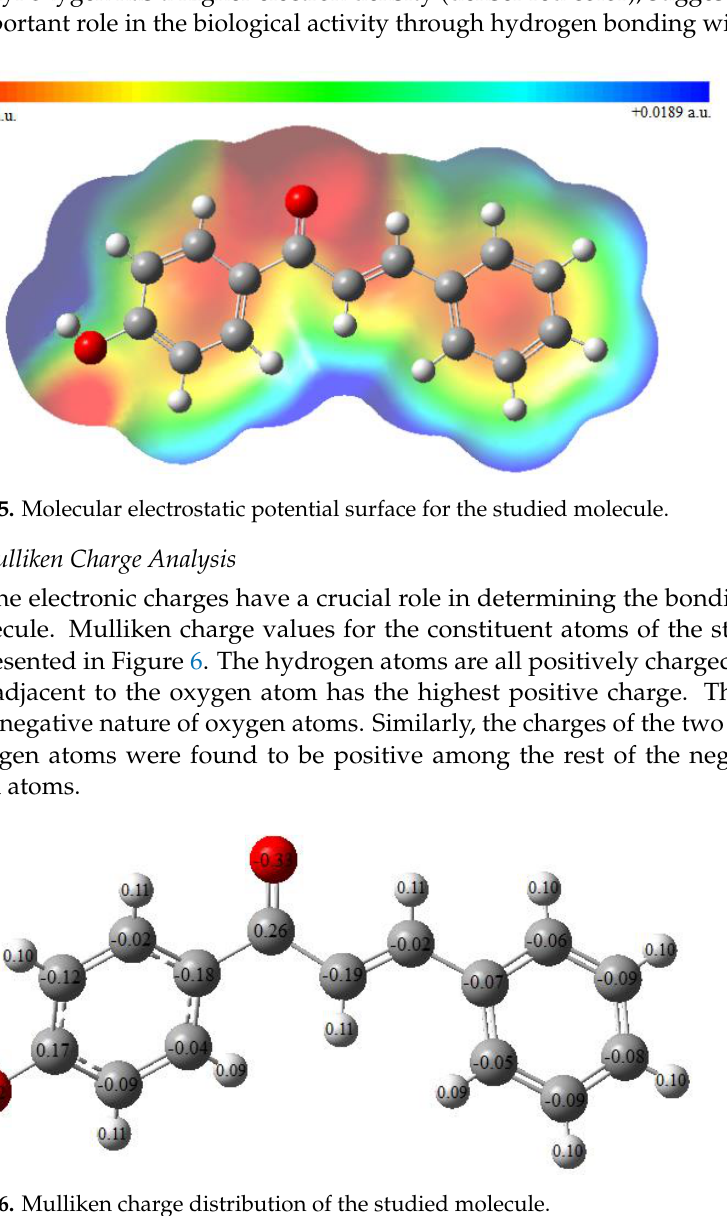
Figure 6. Mulliken charge distribution of the studied molecule.